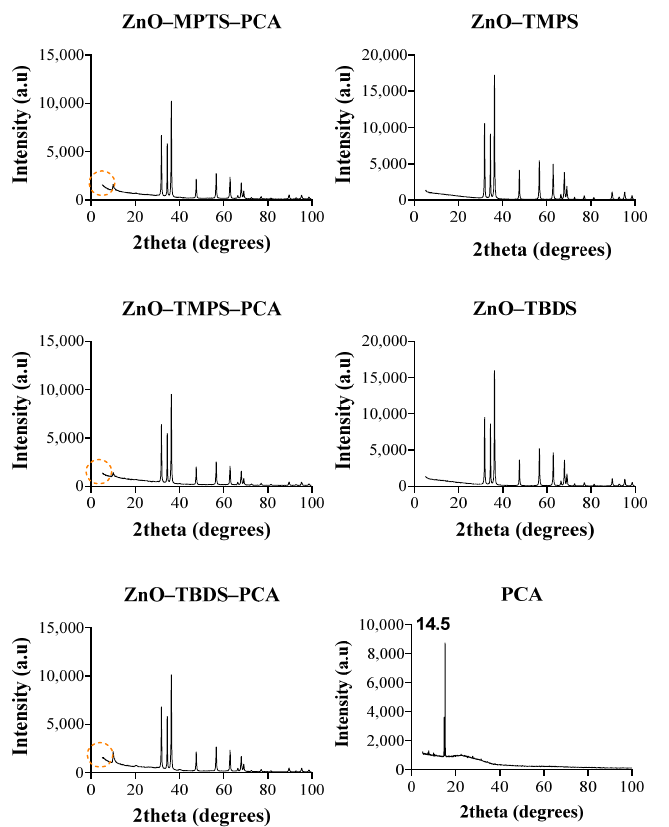
Figure 4. Results of X-ray diffraction analysis of dried powder materials for the PCA prodrug and before and after PCA loading in nanoformulations. The red-dotted circle indicates the presence of PCA in nanoformulations.